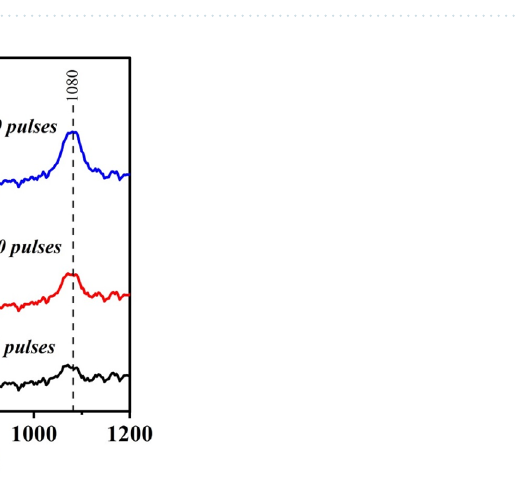
Figure 7. EDX spectra of of B 4 C NPs synthesized at different laser pulses prepared at ( a ) 500, ( b ) 1000 and ( c ) 1500 pulses.